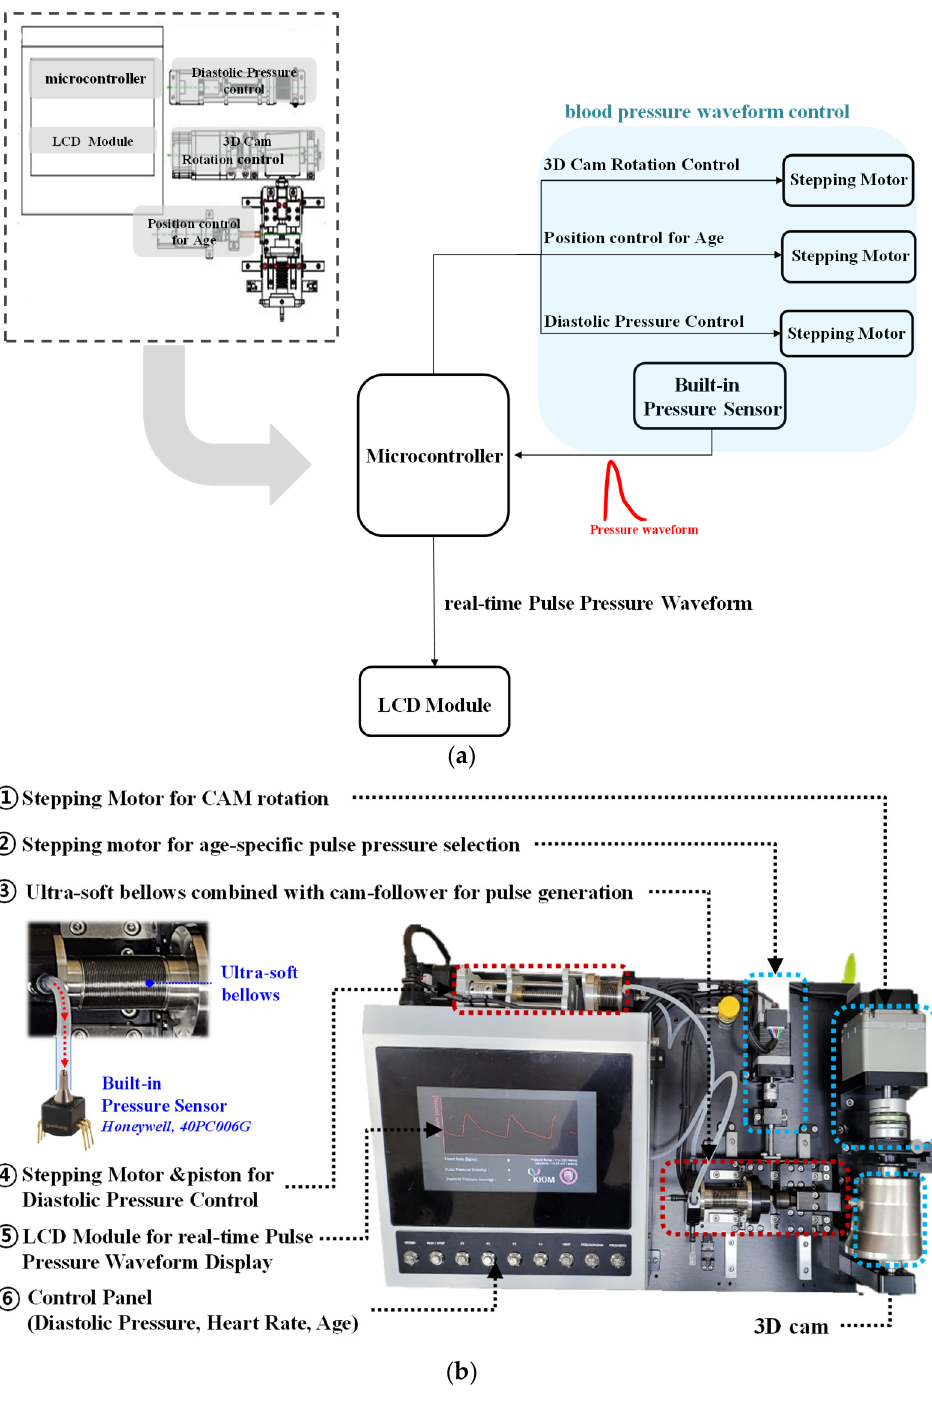
Figure 3. 3D cam-based pulse pressure waveform simulator: ( a ) A conceptual block diagram of the cylindrical 3D cam-based simulator platform capable of generating age-specific pulse pressure waveforms including a 3D cam rotation control motor, an age control motor, and a diastolic pressure control motor; ( b ) the 3D cam-based simulator.